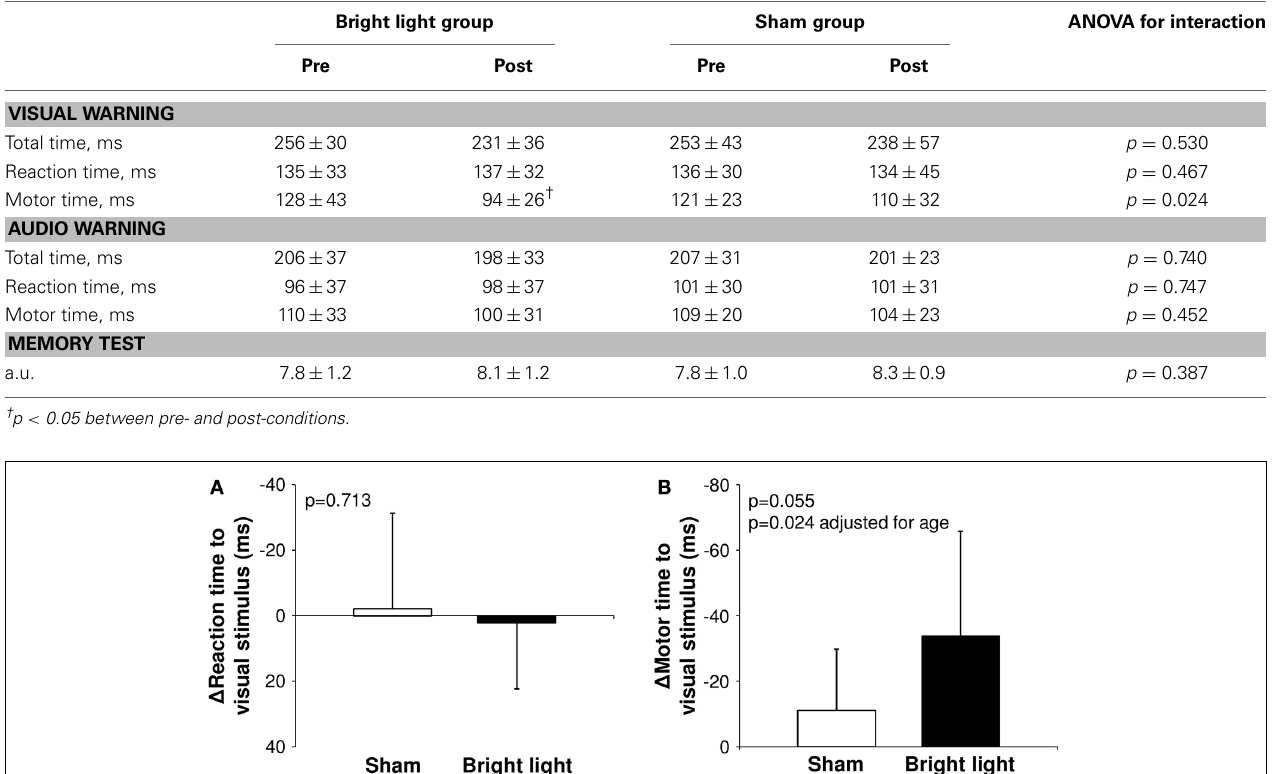
Table 1 | Effects of bright light treatment and sham treatment on psychomotor speed n = 11 for both groups and group × time (treatment) interaction adjusted for age.